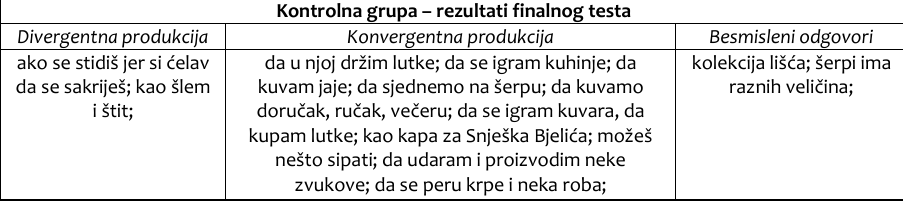
Tabela 3. Odgovori finalnog testa (kontrolna grupa)